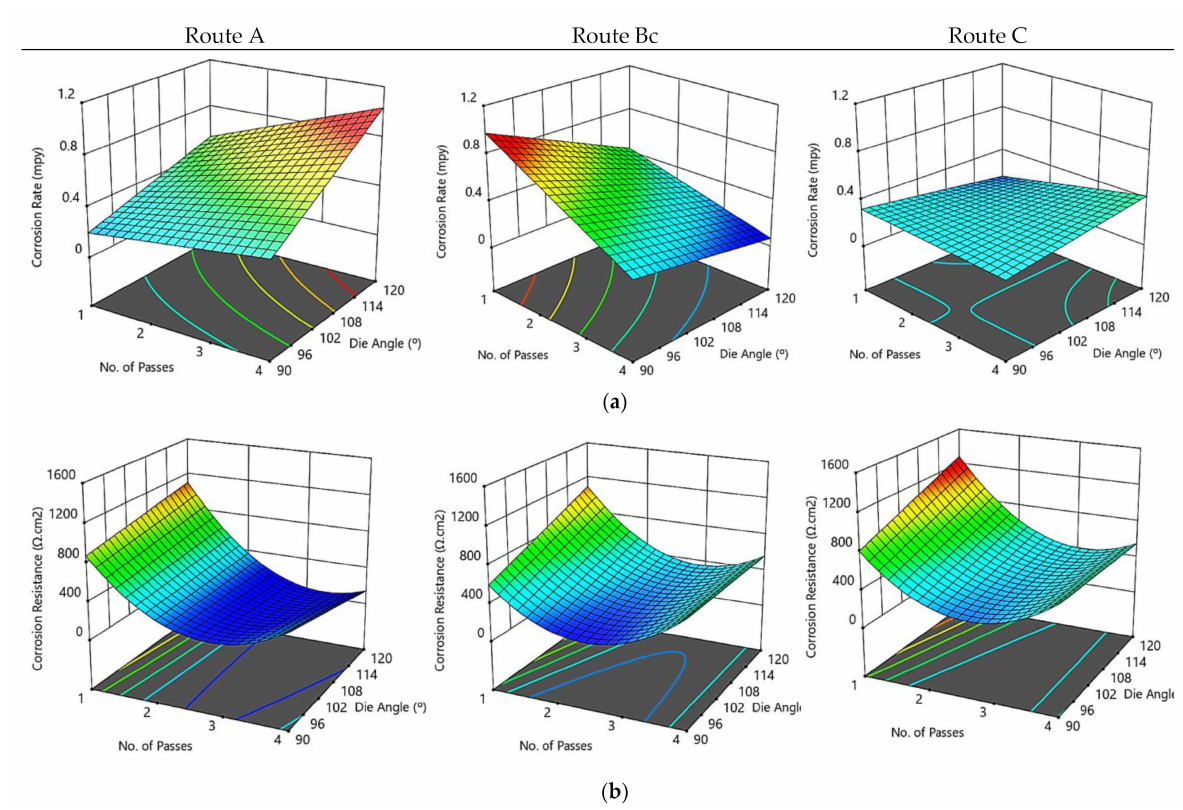
Figure 7. Three-dimensional plot of corrosion rate ( a ) and corrosion resistance ( b ) with ECAP die angle and number of passes at routes A, Bc, and